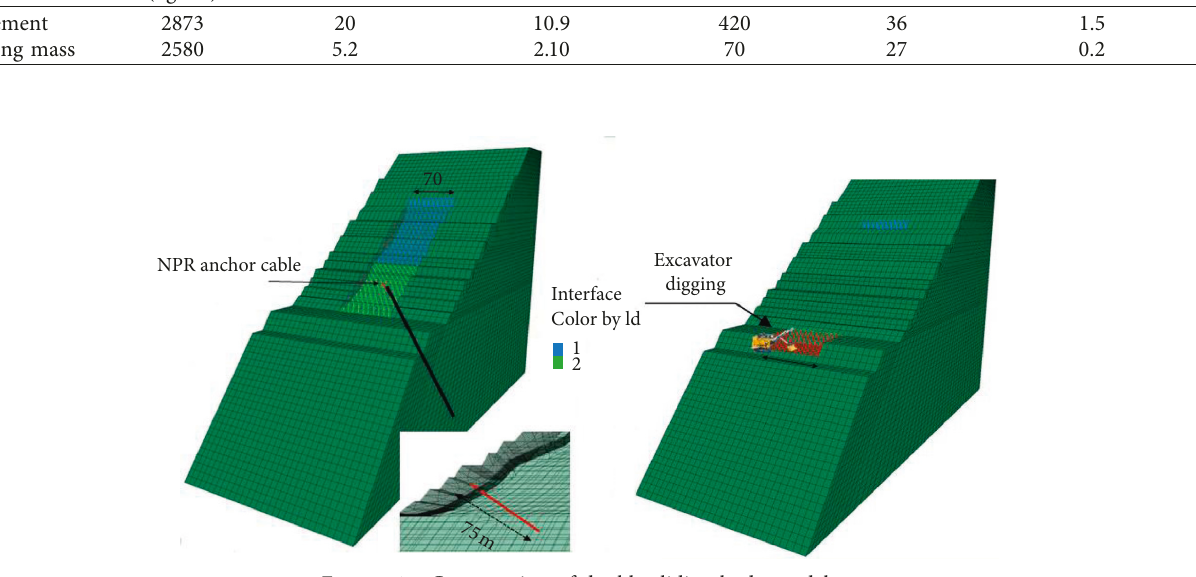
Figure 17: Construction of double-sliding body model.